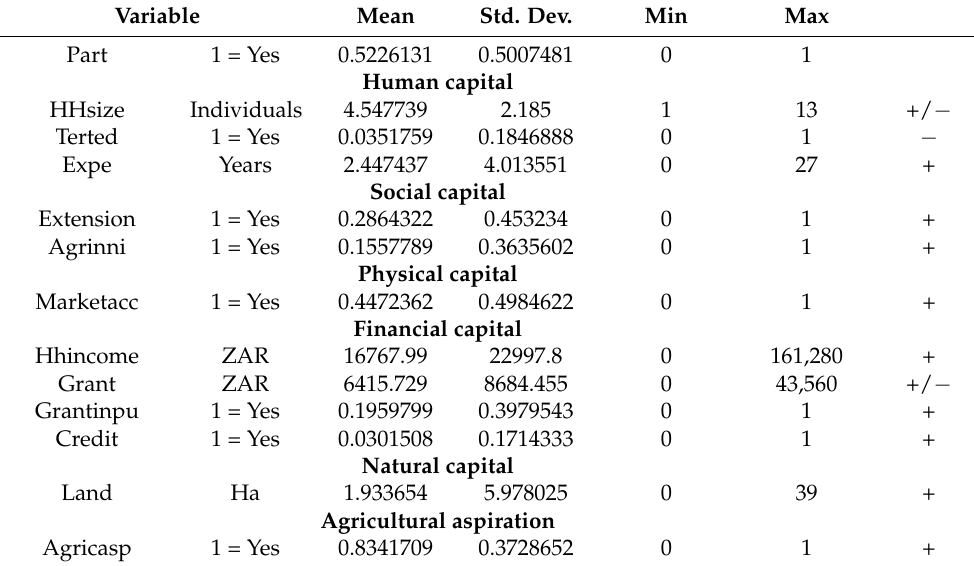
Table 1. Description of